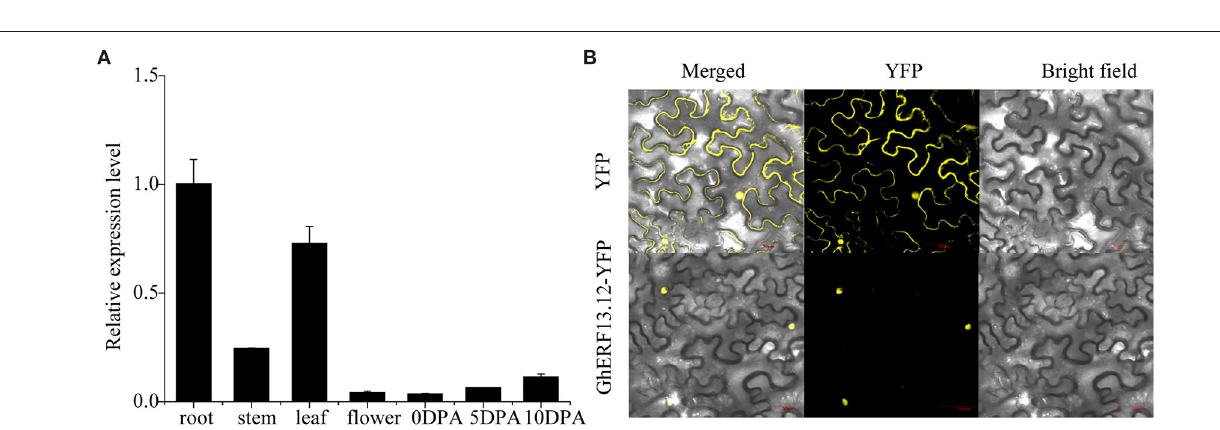
FIGURE 4 | Transcript profile of the GhERF13.12 gene. (A) Tissue-specific expression pattern of GhERF13.12 obtained by qRT-PCR analysis in the root, stem, leaf, and flower at 0, 5, and 10 DPA (days post-anthesis). Fiber samples were taken from ZM24 cotton plants. The standard deviation among three biological replicates is represented by the error bars. (B) Subcellular localization of GhERF13.12 in tobacco